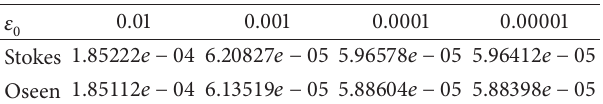
Table 6: Numerical relative error for Newton